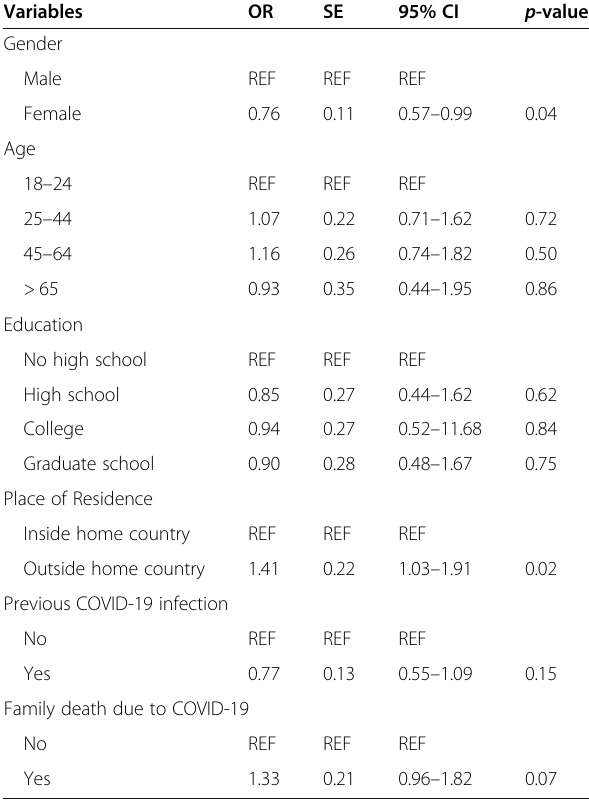
Table 4 Binary Logistic Regression for COVID-19 Vaccine Acceptance by Respondents Characteristics. ( N = 870)